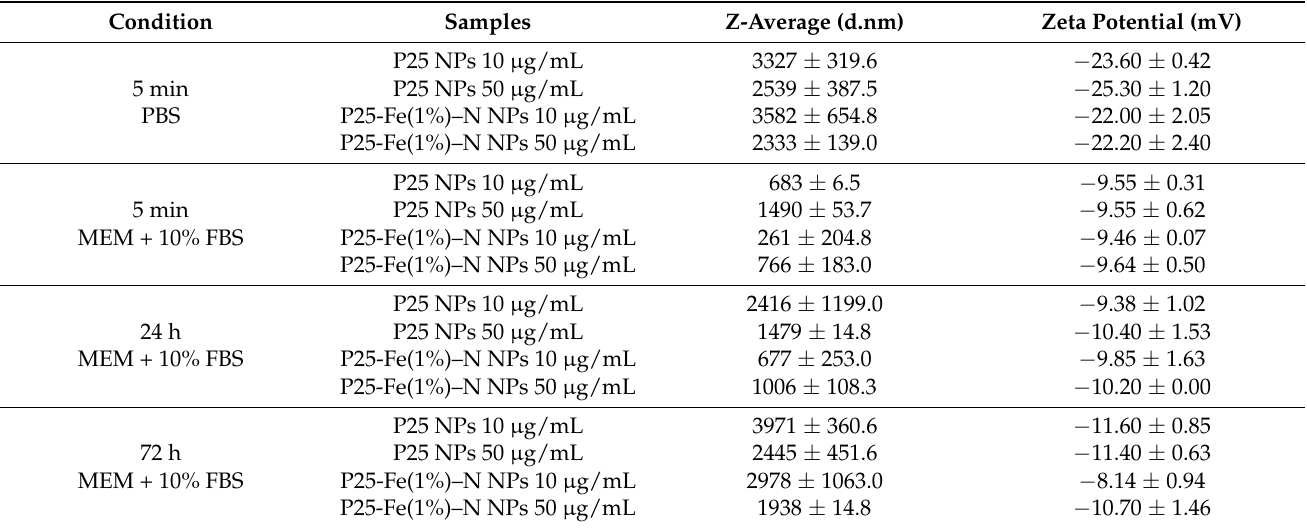
Table 3. Hydrodynamic diameter and zeta potential values measured for TiO 2 NPs dispersed in PBS or culture medium (MEM + 10% FBS) for different periods of time. Results are represented as means ± standard deviation (SD) ( n =